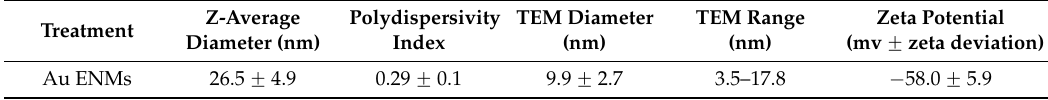
Figure 3. TEM (transmission electron microscopy) micrograph and energy-dispersive X-ray spectroscopy (EDS) spectrum characterizing gold engineered nanomaterials (ENMs). Copper detected is result of the use of Cu TEM grids. cps: counts per second. Table 1. Nanomaterial characterization data (mean ± standard deviation, unless otherwise noted). Hydrodynamic diameter (Z-average diameter), measured by dynamic light scattering, based on intensity weighted size distribution measurements. TEM: transmission electron microscopy.